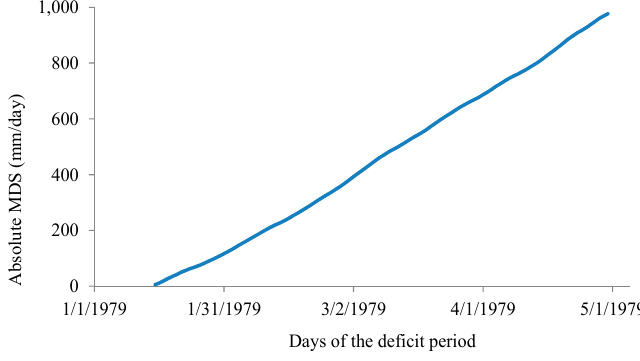
Figure A4 . Absolute Meteorological Deficit Sum (MDS) for a selected drought event. Figure A4. Absolute Meteorological Deficit Sum (MDS) for a selected drought